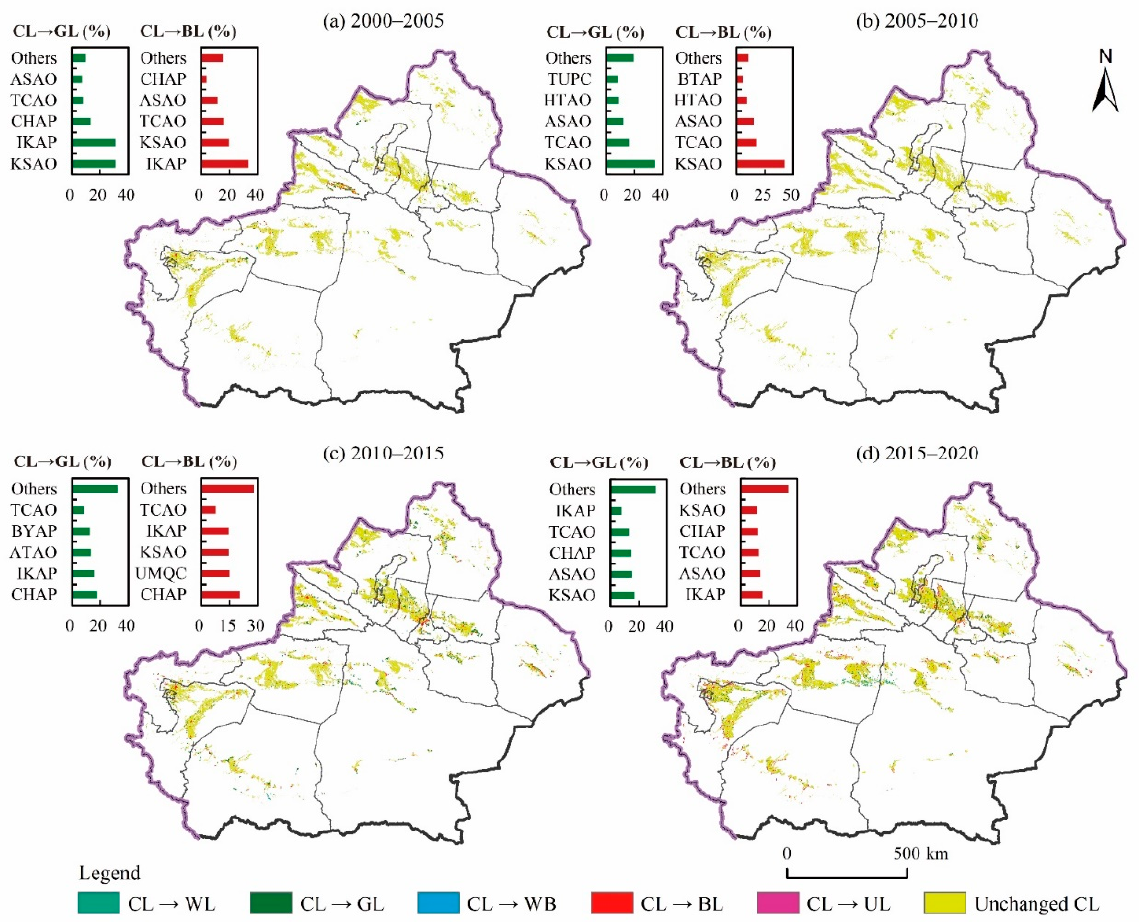
Figure 5. Spatial distribution of lost cropland in Xinjiang: ( a ) during 2000–2005; ( b ) during 2005–2010; ( c ) during 2010–2015; and ( d ) during 2015–2020.